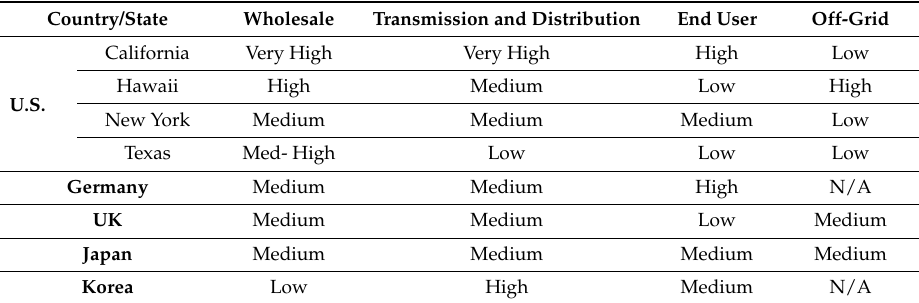
Table 2. Level of support for energy storage in leading countries (adapted from [25]).